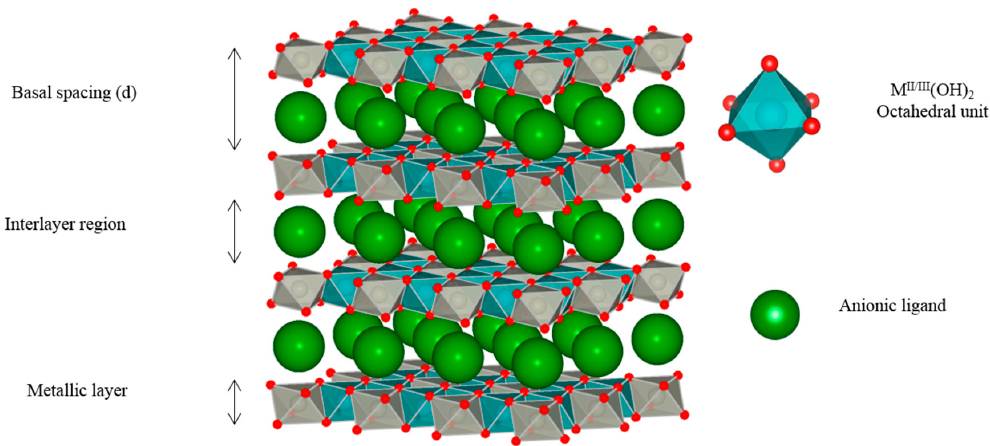
Figure 1. Layered double hydroxides (LDHs) are built up from sheets of [M II 1 − x M III x (OH) 2 ] x+ octahedral units intercalated with anions. Each octahedron is formed from a metal cation (M II or M III ) 6-coordinated to OH − groups (red spheres).